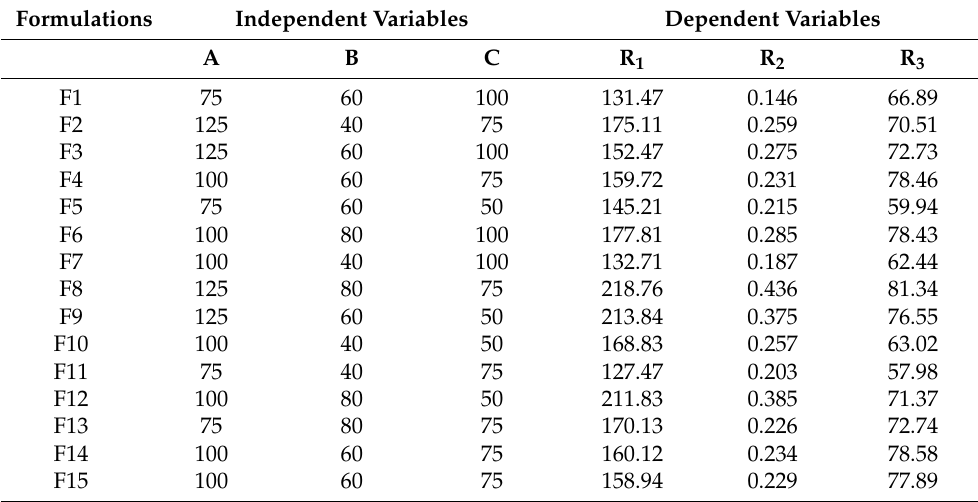
Table 2. Composition of PPN-LPHNPs with their experimental value of respective responses. Formulations Independent Variables Dependent